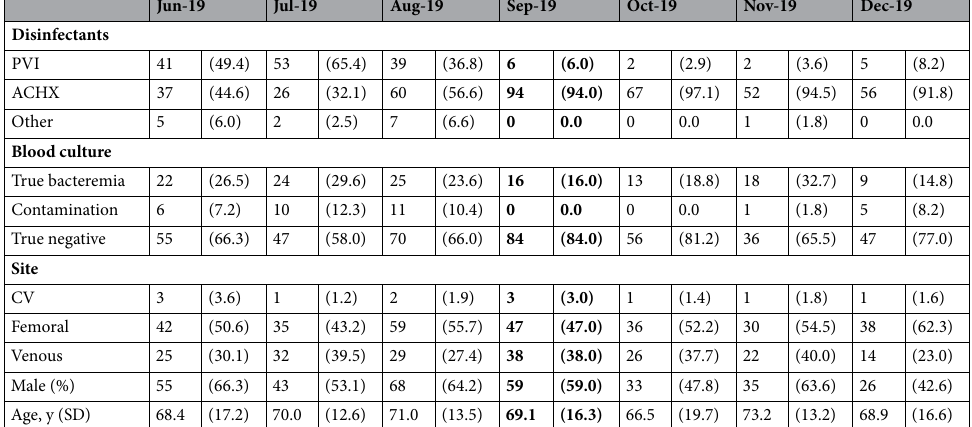
Table 3. Monthly data for blood cultures in emergency department. Total number of blood cultures is categorized as three groups, including true bacteremia, contamination, and true negative. Disinfectants categories indicate the proportions of PVI (10% aqueous povidone-iodine), ACHX (1.0% alcohol/ chlorhexidine gluconate), and Other disinfectants usage. Site category does not include Other (recently inserted arterial catheter and implanted port) and Venous catheter (recently inserted venous catheter). September 2019 was at the threshold (institution of policy change; bold